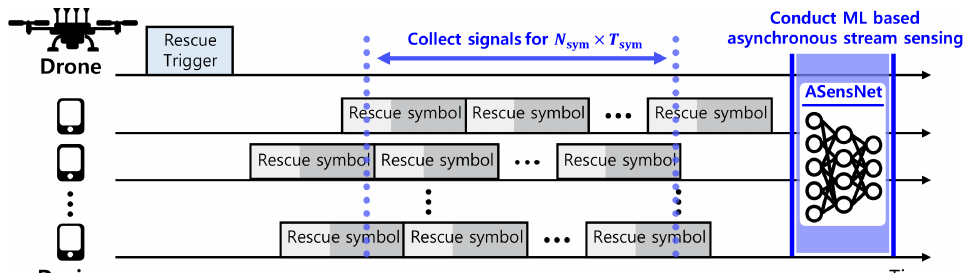
Figure 3. Disaster scenario in which all cell sites are destroyed by a natural disaster.